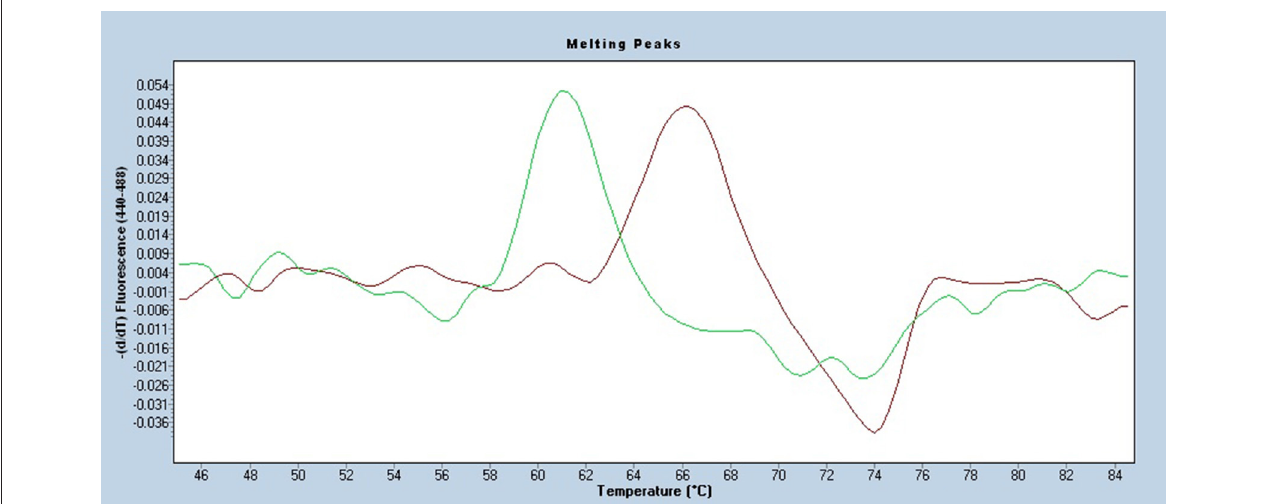
FIGURE 2 | AsperGenius ® based melting curve analysis of a potentially present L98H mutation in a BAL sample containing A. fumigatus DNA. The sample contained A. fumigatus wild type DNA (green curve in the range 61.0–64.0 ◦ C) compared to the L98H positive control DNA (brown curve in the range 65.5–68.5 ◦